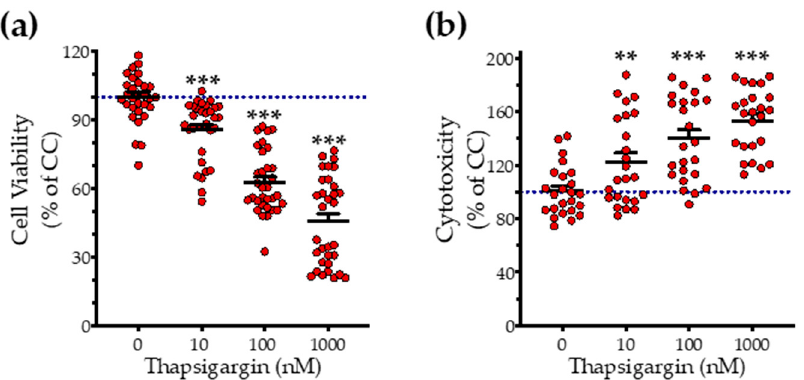
Figure 1. Concentration-dependent e ff ect of thapsigargin on hepatic-cell viability. HepG2 cells were serum-starved for 8 h and treated with 0, 10, 100 and 1000 nM of thapsigargin for 16 h. Micro-cultures were assayed for the XTT conversion ( a ) to assess cell viability. Cell supernatant was collected and processed for the LDH activity ( b ) to determine cytotoxicity. Each line represents mean ± SEM from four independent experiments. Data are expressed as a percentage of the control conditions (CC). CC refer to vehicle-treated cells that correspond to 0 nM of the ER stressor and 0.1% DMSO (the vehicle). ** p ≤ 0.01; *** p ≤ 0.001, when compared to CC.